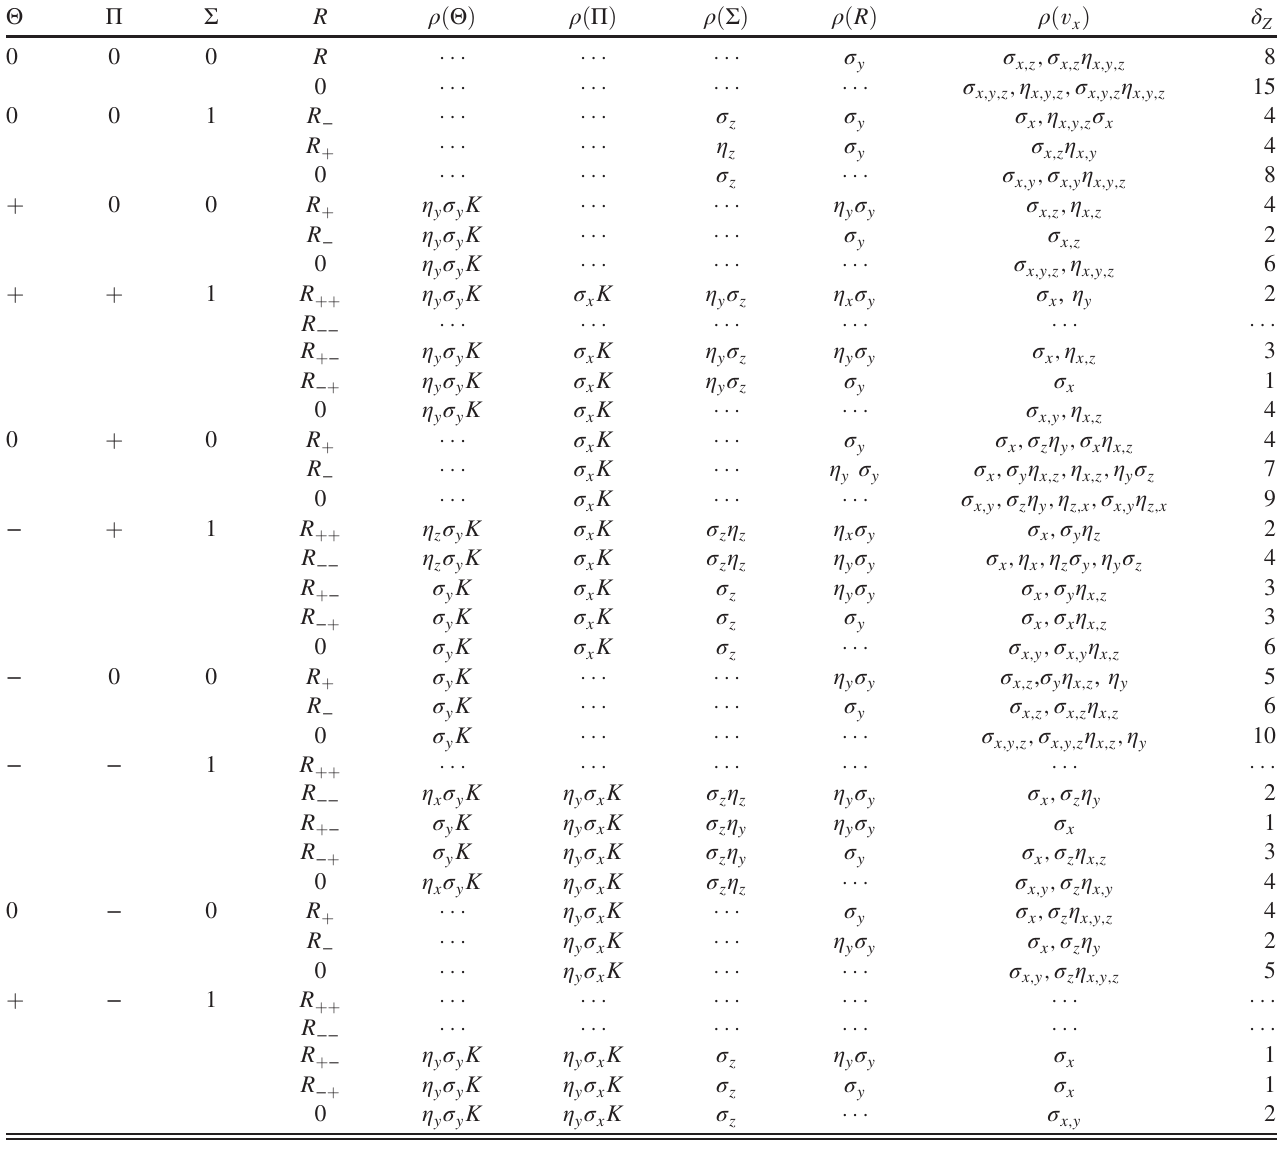
TABLE III. δ for two degenerate Dirac cones: Same as Table II but for doubly degenerate Dirac cones. Center dots in the δ Z signify symmetry groups which cannot support the algebra of a Dirac